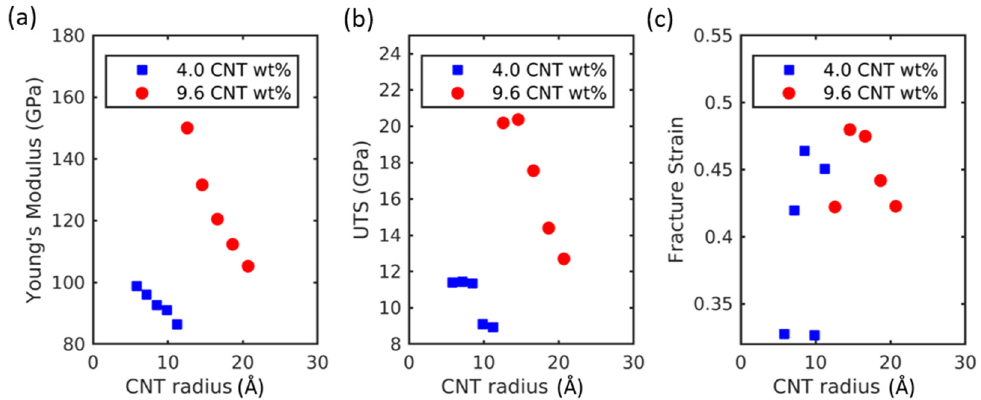
Figure 5. ( a ) Young’s modulus, ( b ) ultimate tensile strength, and ( c ) fracture strain of CNT-Al composites with the variation in the CNT radius .